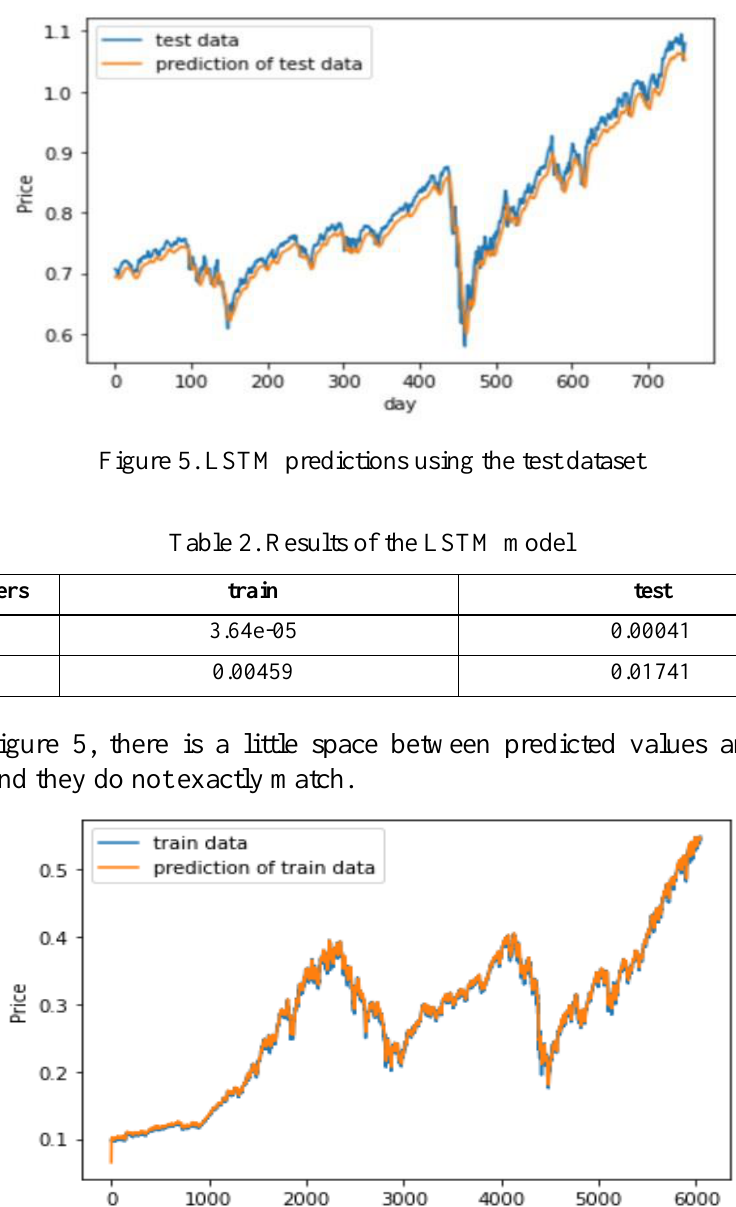
Figure 4. LSTM predictions using the train dataset